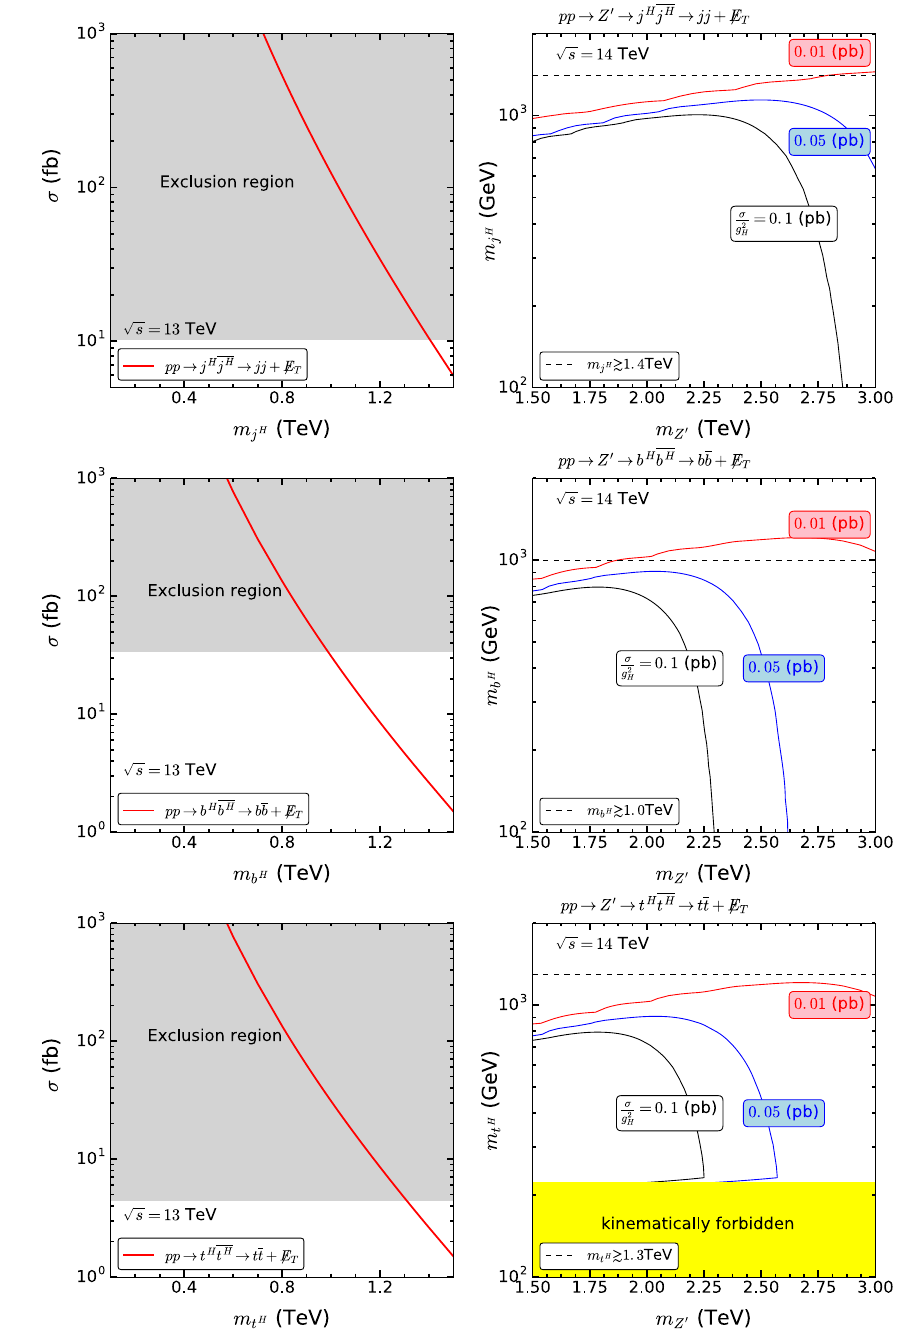
Fig. 3 The new quark searches in Spectrum B (cid:2) . Left column: the cross sections for 2 j + (cid:3) E T , bb + (cid:3) E T , and tt + (cid:3) E T channels via the important strong √ s = 13TeV as interactions at functions of m Q H . The gray shaded regions are excluded by recent ATLAS SUSY squark searches. Right column: contours of the production cross √ s = 14TeV for Z (cid:2) sections at exotic